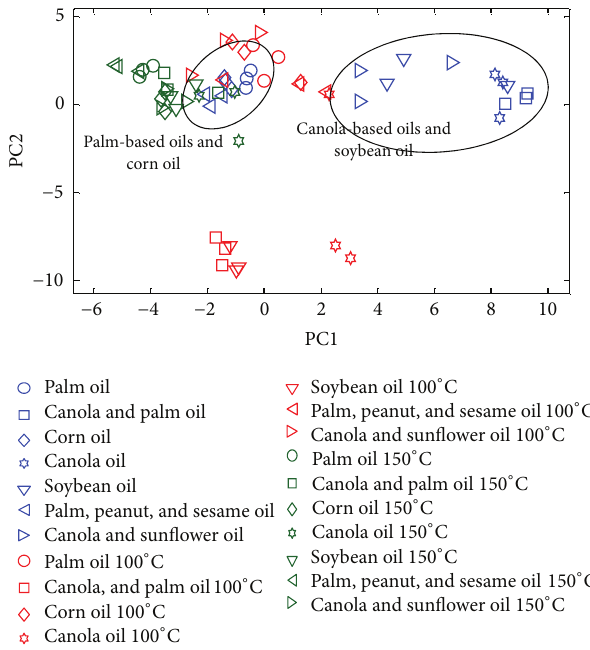
Figure 3: The scores plot of PC2 versus PC1 of the peak table obtained from FTIR